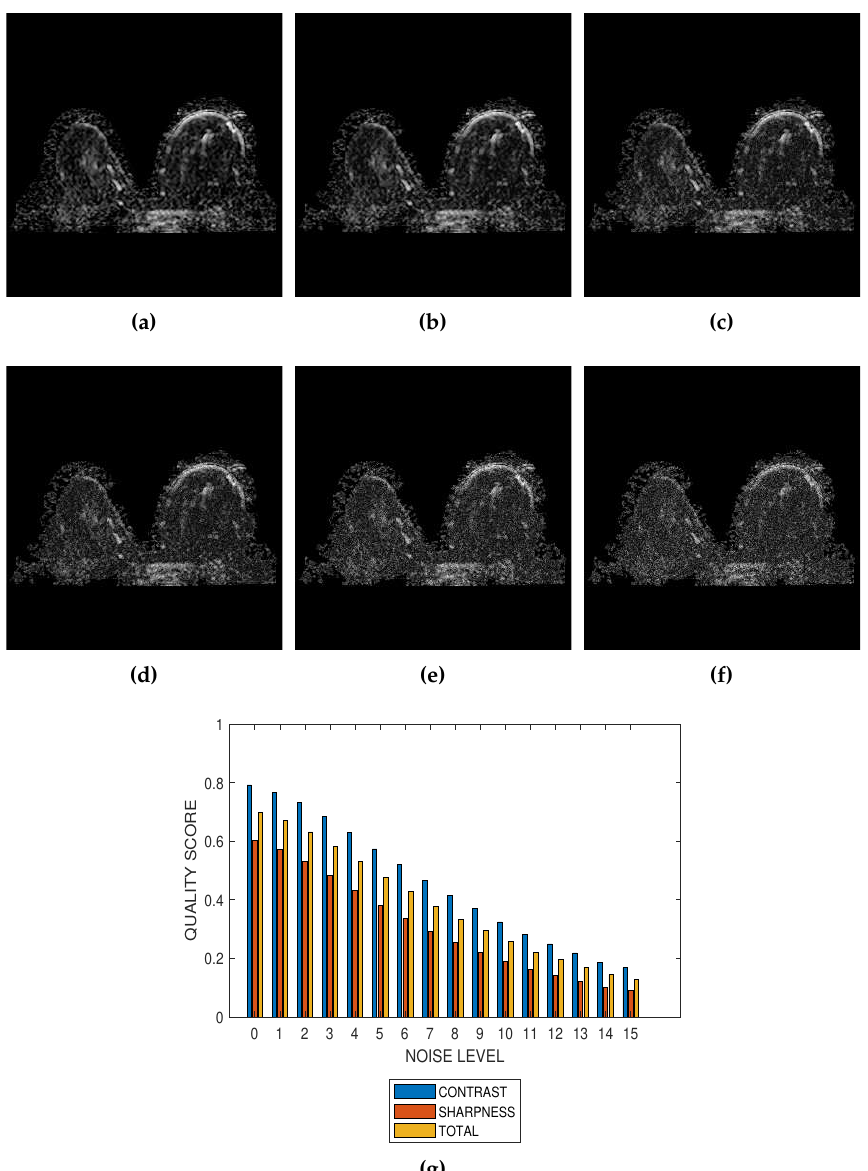
Figure 3. ( a ) A breast MRI slice provided by the RIDER project of The Cancer Imaging Archive (TCIA) and its degraded versions at Rician noise levels ( b ) 3 percent, ( c ) 6 percent, ( d ) 9 percent, ( e ) 12 percent and ( f ) 15 percent. ( g ) Variation of contrast, sharpness and total quality scores for Rician noise levels that vary from 0 percent to 15